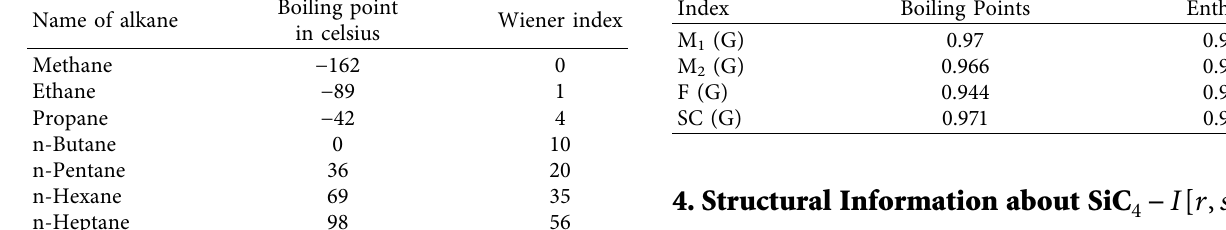
Table 1: The correlation coefficient between BP and W-index. Boiling point Name of alkane